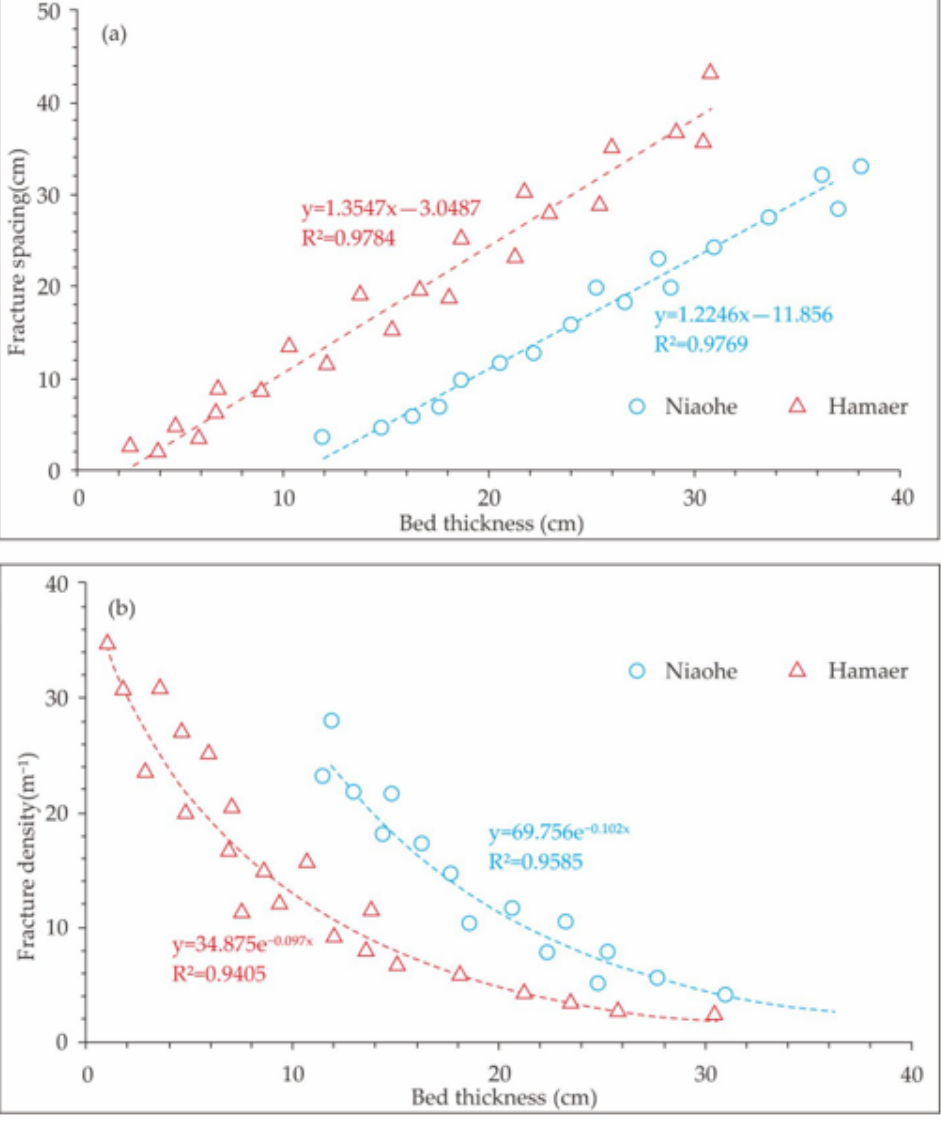
Figure 10. Impacts of mechanical layer thickness on fracture intensity in Qingshankou shale: ( a ) Mechanical layer thickness vs. fracture spacing; ( b ) Mechanical layer thickness vs. fracture density. NHT-1, NHT-2, NHT-3, and YHT-1 represent survey locations, respectively.